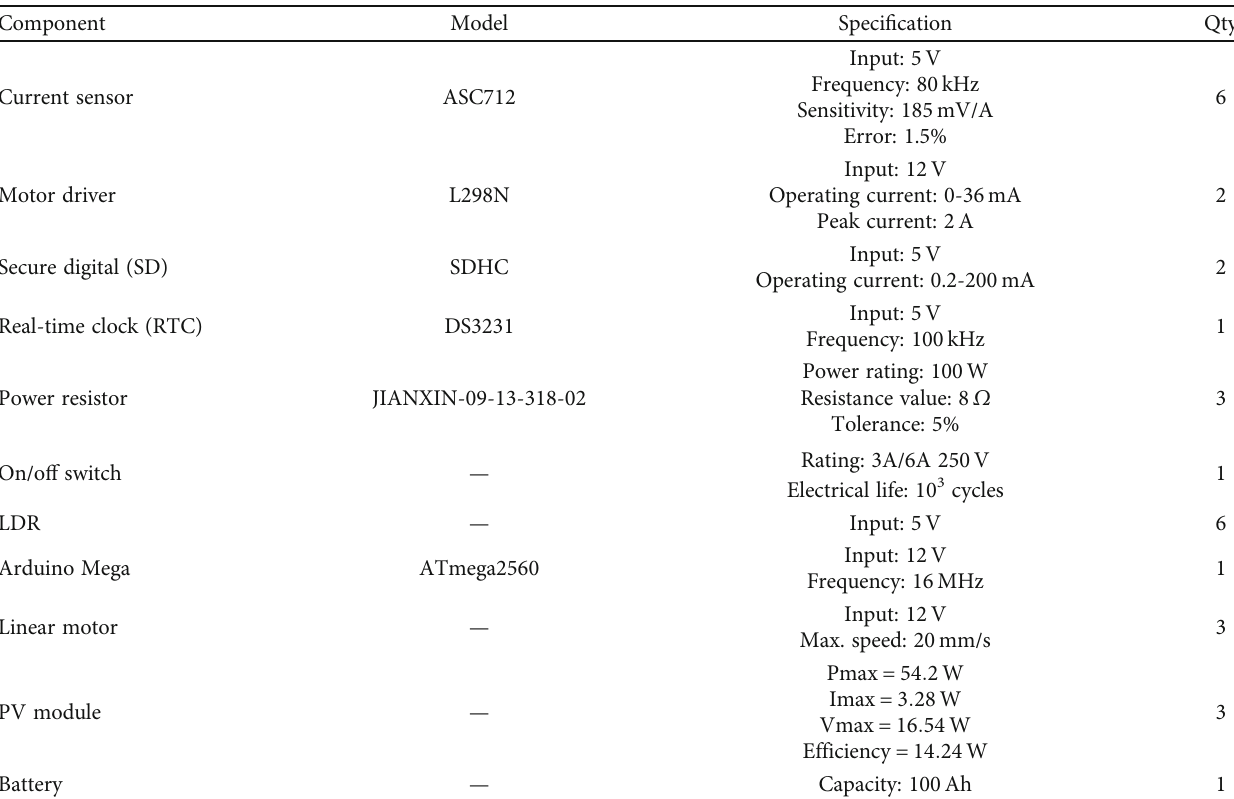
Figure 1: (a) SAST and (b) DAST CAD Table 1: The electrical setup for the experiment.